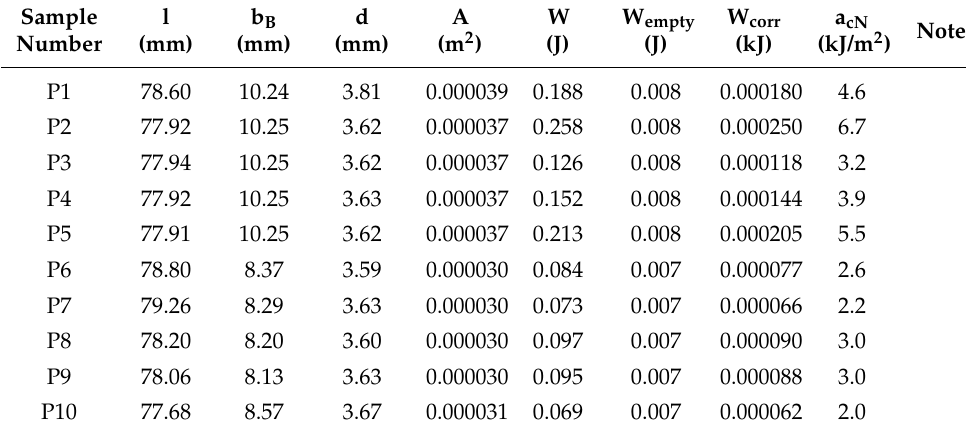
Table A10. Results of the notched impact tests and unnotched impact tests of P_PP.